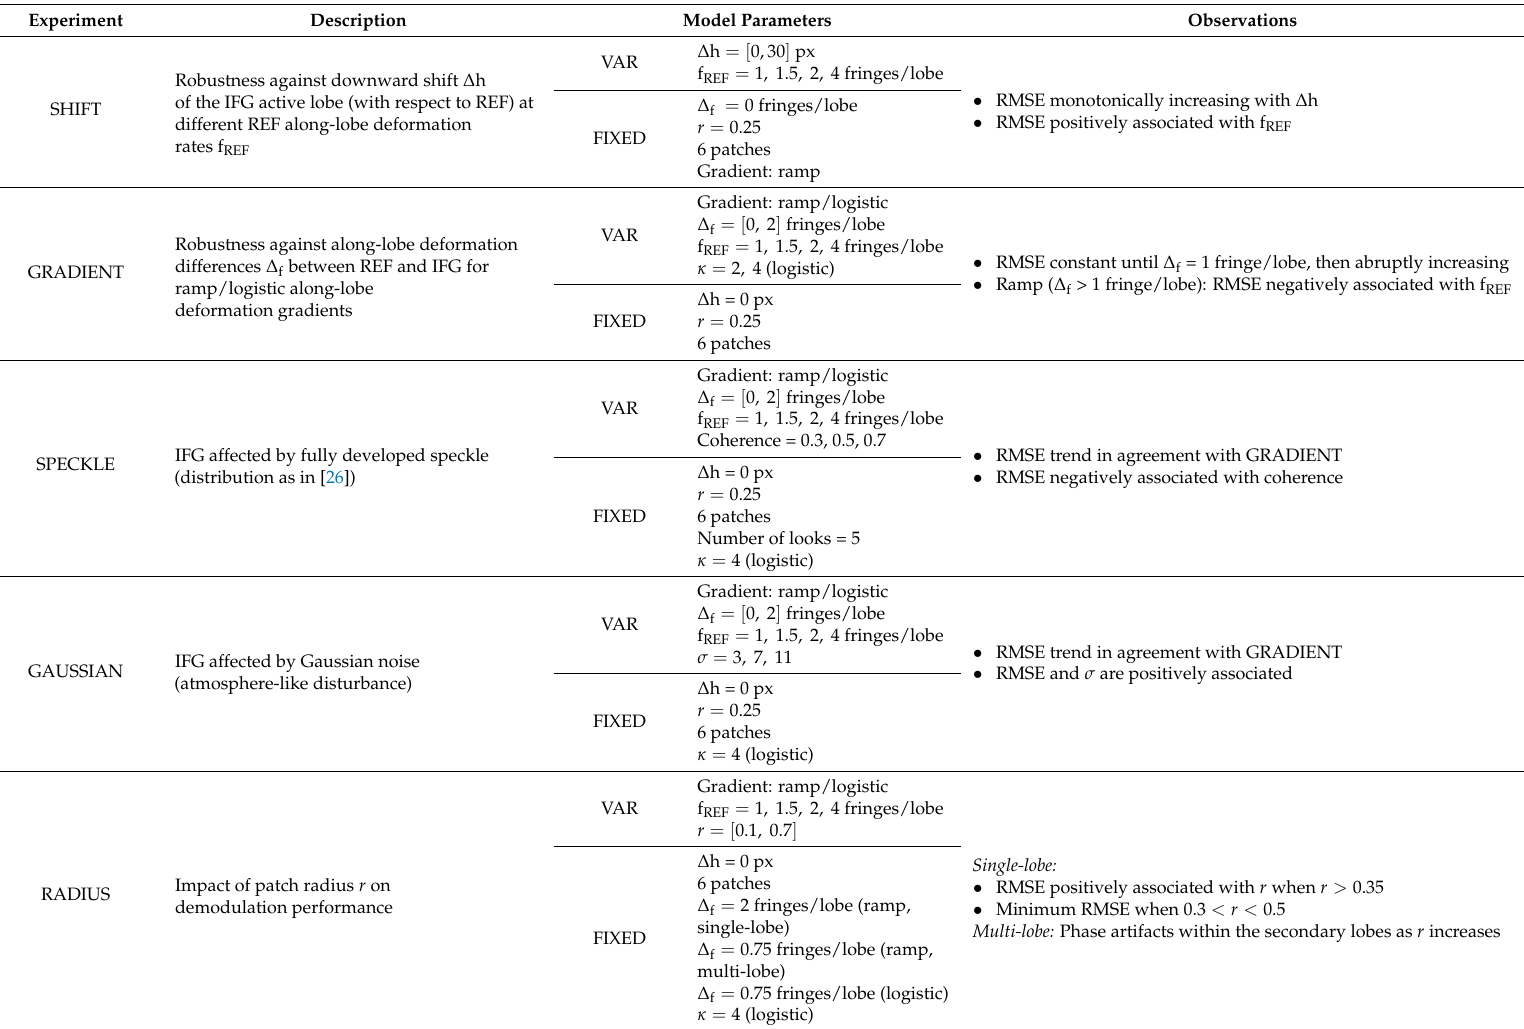
Table 3. Sensitivity analysis with simulated data. Overview of the simulation experiments and